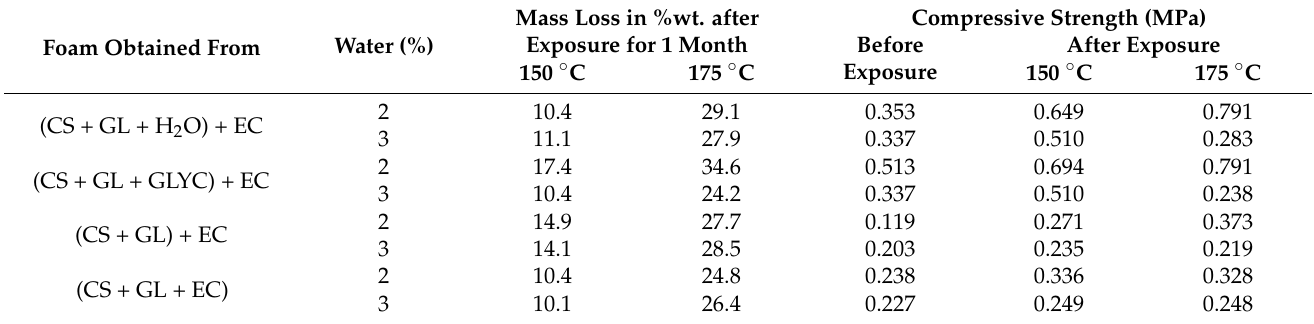
Table 8. Mass loss and compressive strength after exposure for one month at 150 and 175 ◦ C.